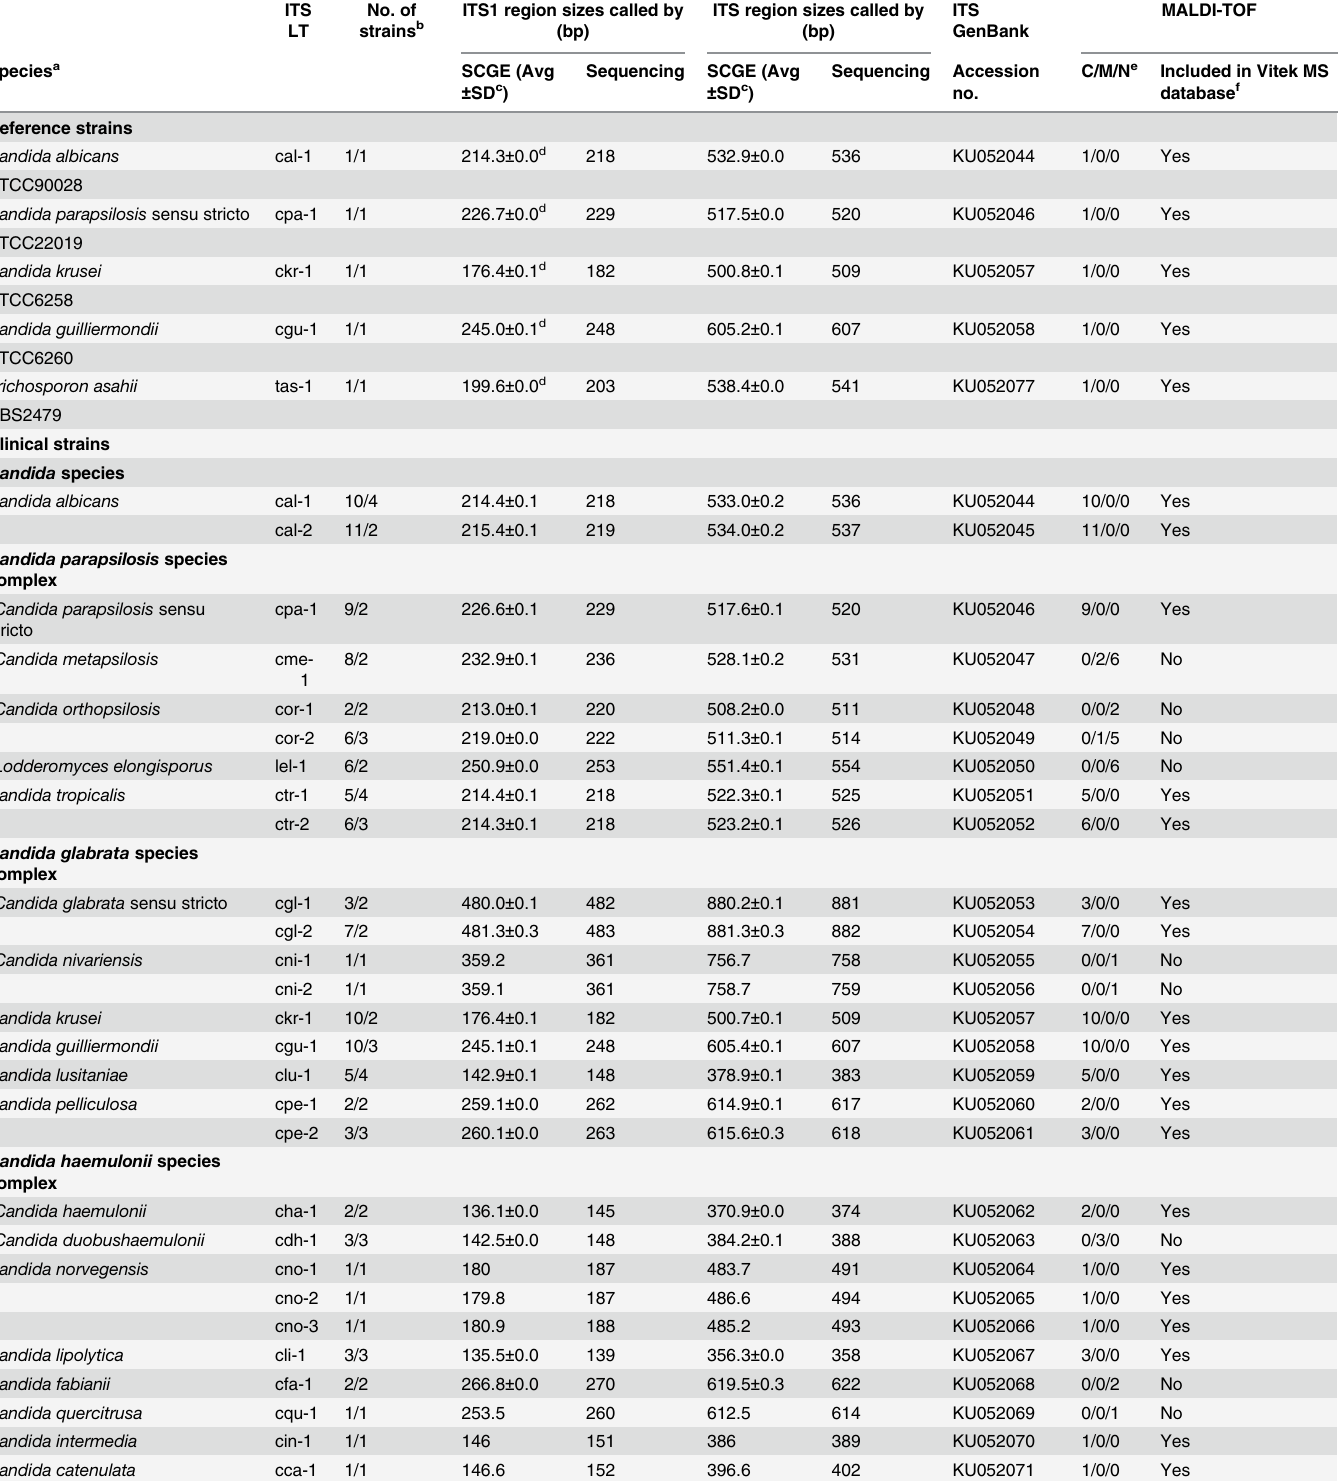
Table 1. Summarization of ITS1 and ITS sizes called by SCGE and DNA sequencing for five reference strains and 151 clinical isolates used for establishment of the SCGE ITS length type (LT)